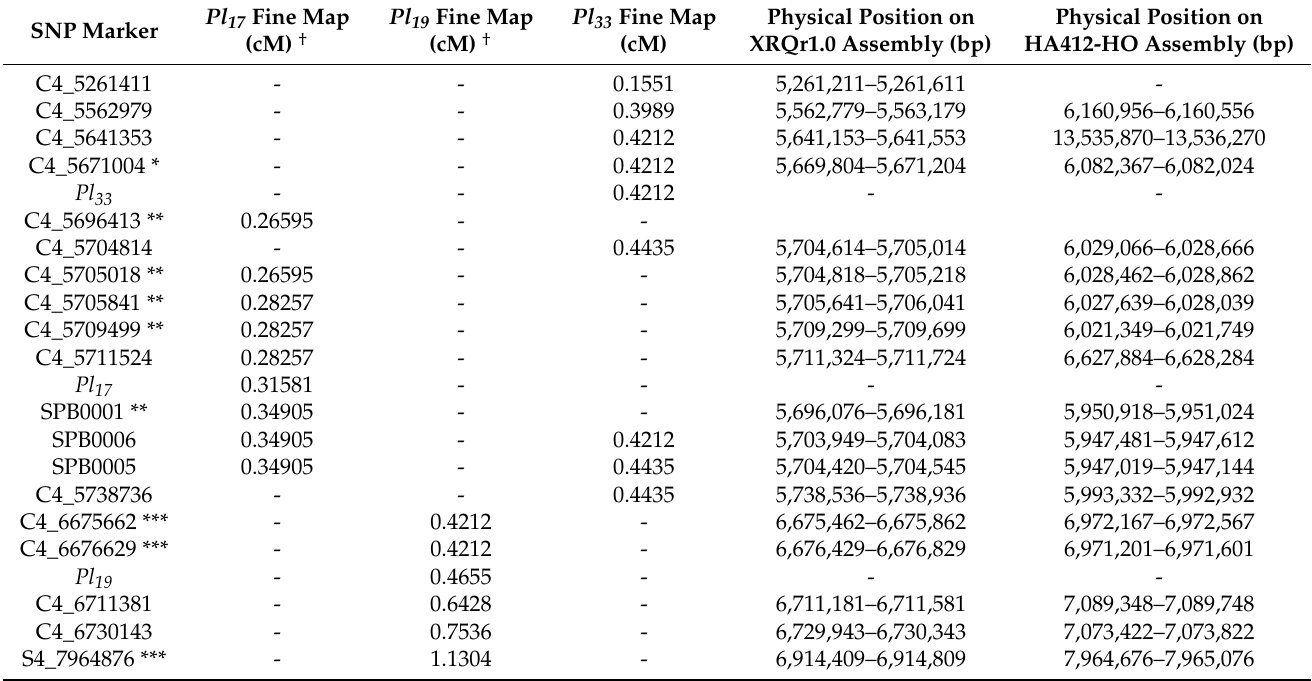
Table 5. Map positions of the SNP markers linked to Pl 17 , Pl 19 , and Pl 33 on sunflower chromosome